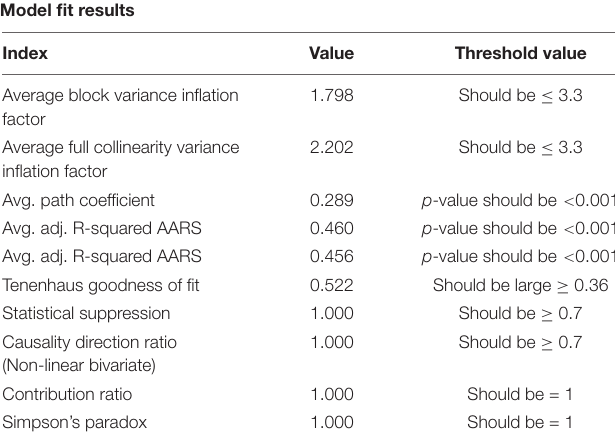
TABLE 4 | Model fitness indices.